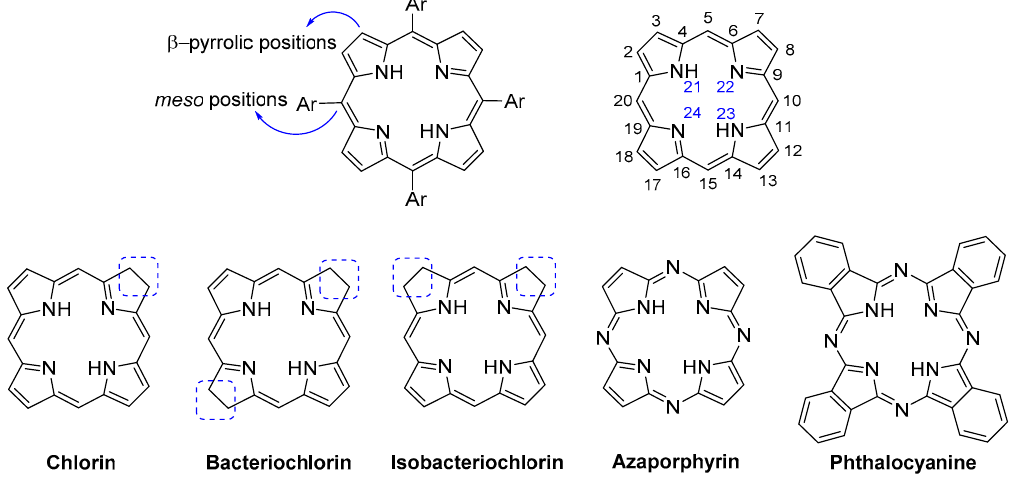
Figure 2. General structure of meso -tetraarylporphyrins and the IUPAC numbering of the porphyrinic nucleus. The structures of other nucleus that will be mentioned throughout the manuscript are also depicted.